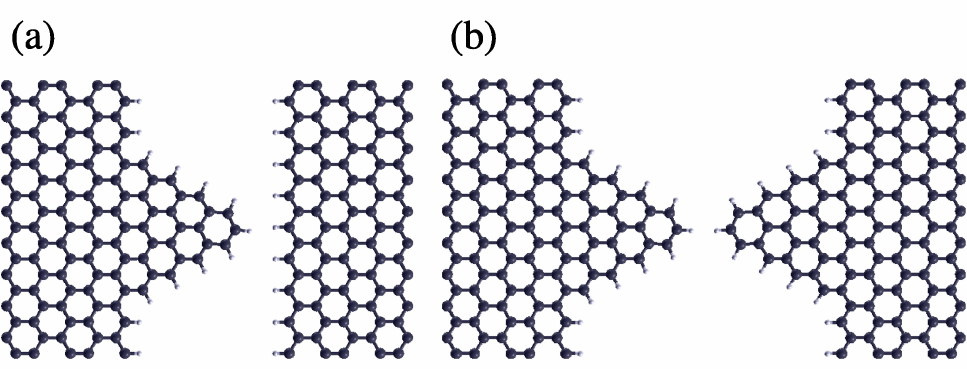
Figure A1. Atomic coordinates used to run the ab initio simulation in the wedge–edge ( a ) and wedge– wedge ( b ) configurations. Black and white spheres represent carbon and hydrogen atoms,